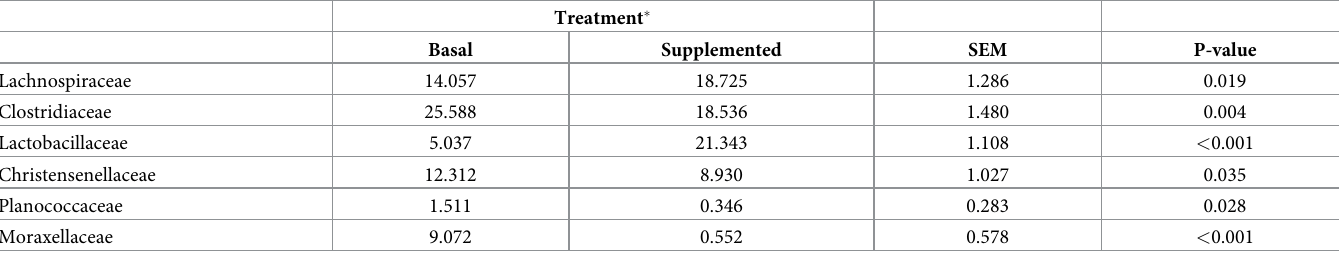
Table 7. Effect of supplementation of CH-YBG during gestation/lactation on differential relative abundance of bacterial taxa at the family level in sow faeces on expected farrowing date. (least-square mean values with their standard error of means). Treatment